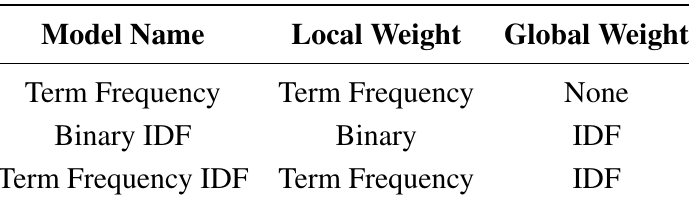
Table 2. The three models used for document indexing